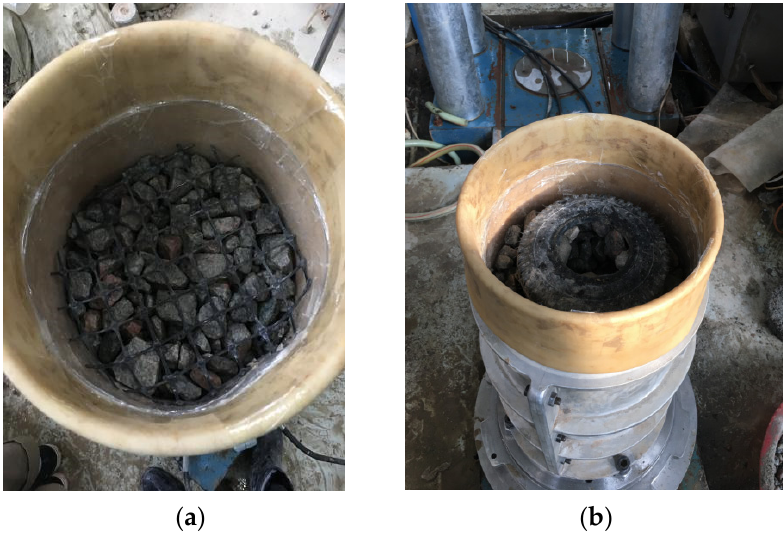
Figure 4. Test reinforcement material: ( a ) geogrid; ( b ) tyres. Table 2. Engineering properties of biaxial